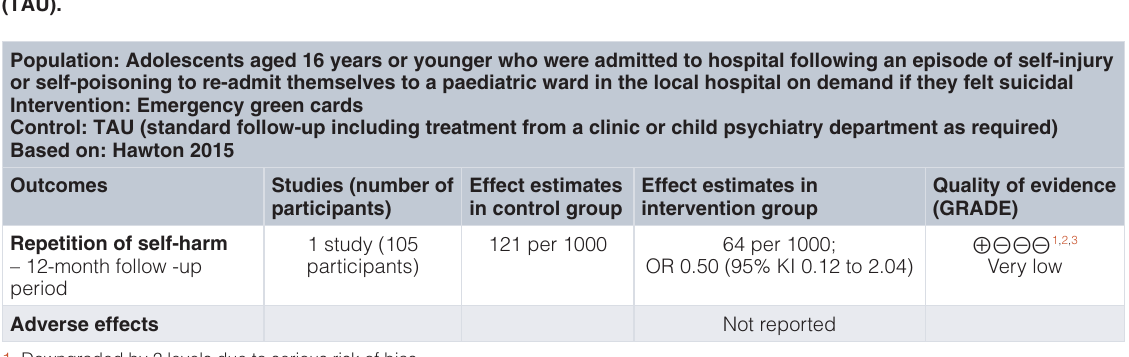
Table 14. GRADE-assessment: Interventions for existing self-harm: emergency green cards versus treatment as usual (TAU).